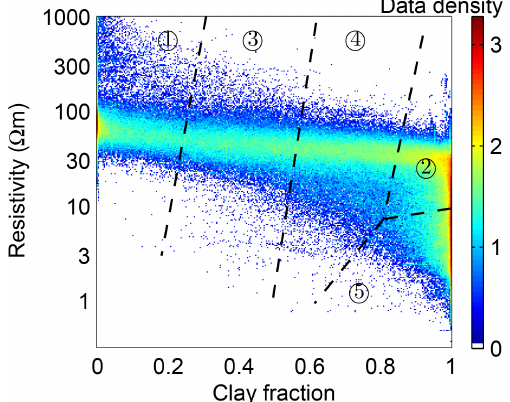
Figure 9. Data cloud of geophysical resistivity values and clay- fraction values. Dotted black lines indicate cluster interfaces and cluster are labeled with numbers. The cloud color represents bin- wise data density (300 bins), which are shown in logarithmic scale.